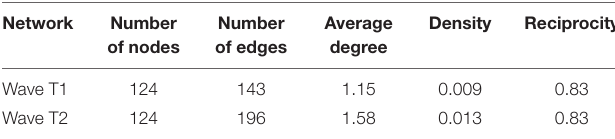
TABLE 3 | Descriptive statistics of the used